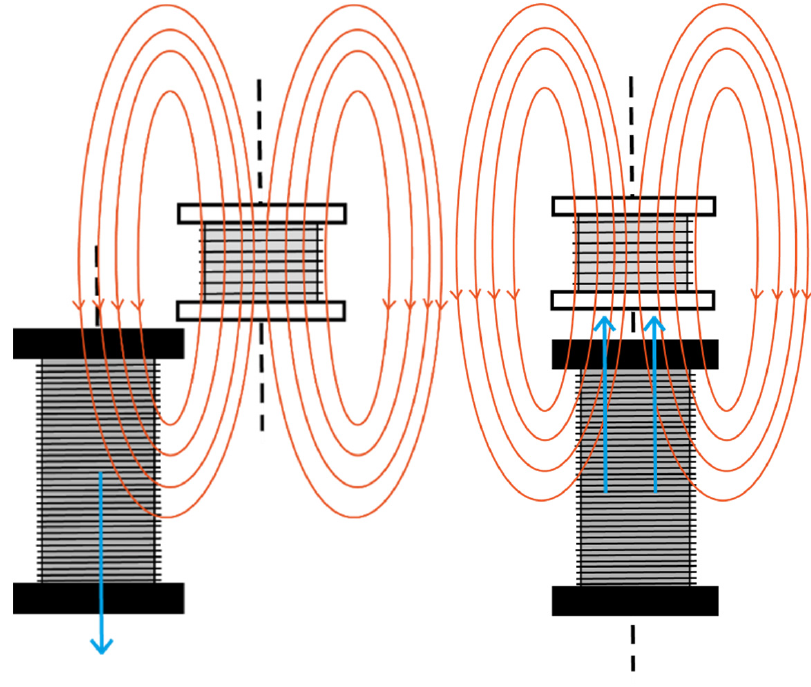
Figure 2. Induced voltage placing the secondary coil with its axial axis vertical.